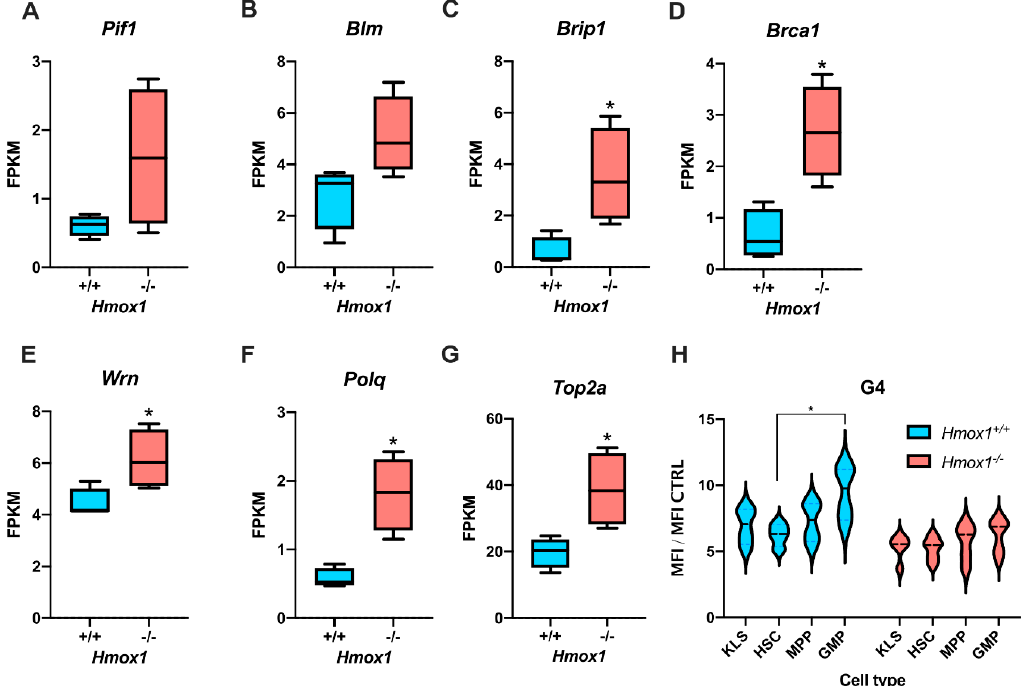
Figure 1. Mouse hematopoietic stem cells from Hmox1 − / − mice had a higher expression of genes associated with G4 unwinding and showed lower G4 staining. The expression of ( A ) Pif1 , ( B ) Blm , ( C ) Brip1 , ( D ) Brca1 , ( E ) Wrn , ( F ) Polq , and ( G ) Top2a was assessed with RNA-Seq in fluorescence-activated cell-sorting (FACS)-sorted phenotypic bone marrow hematopoietic stem cells (HSCs) (data source: [42]). The box-and-whiskers graphs show the median, 25th and 75th percentile (box) minimum, and maximum values (whiskers) of the FPKM (fragments per kilobase million), n = 4, * p < 0.05, Mann– Whitney test. ( H ) G4 staining shown as the mean fluorescence intensity (MFI) ratio of cells stained with anti-G4 antibodies and the background fluorescence (secondary antibodies only) in hematopoietic stem and progenitor cells (KLS), HSCs, multipotent progenitors (MPPs), or granulocyte-monocyte progenitors (GMPs) from Hmox1 +/+ and Hmox1 − / − mice, n = 4–5, violin plot, * p < 0.05, two-way ANOVA with a Bonferroni post hoc test, for genotype p = 0.002.